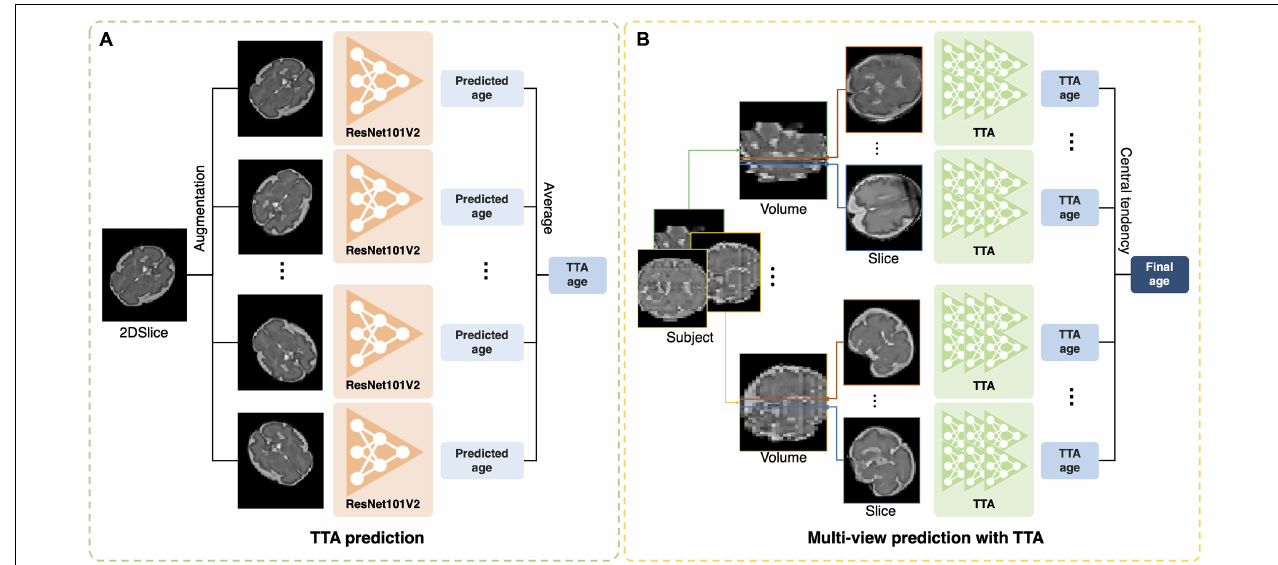
FIGURE 2 | Illustration of test-time augmentation (TTA) and brain age prediction using multiplanar slices. (A) TTA creates multiple predictions by augmentation of a single slice and averages them to improve accuracy. (B) Multiplanar slices in orthogonal directions are used to predict brain ages. The measures of central tendency for multiple predictions from the multiplanar slices were calculated after TTA.